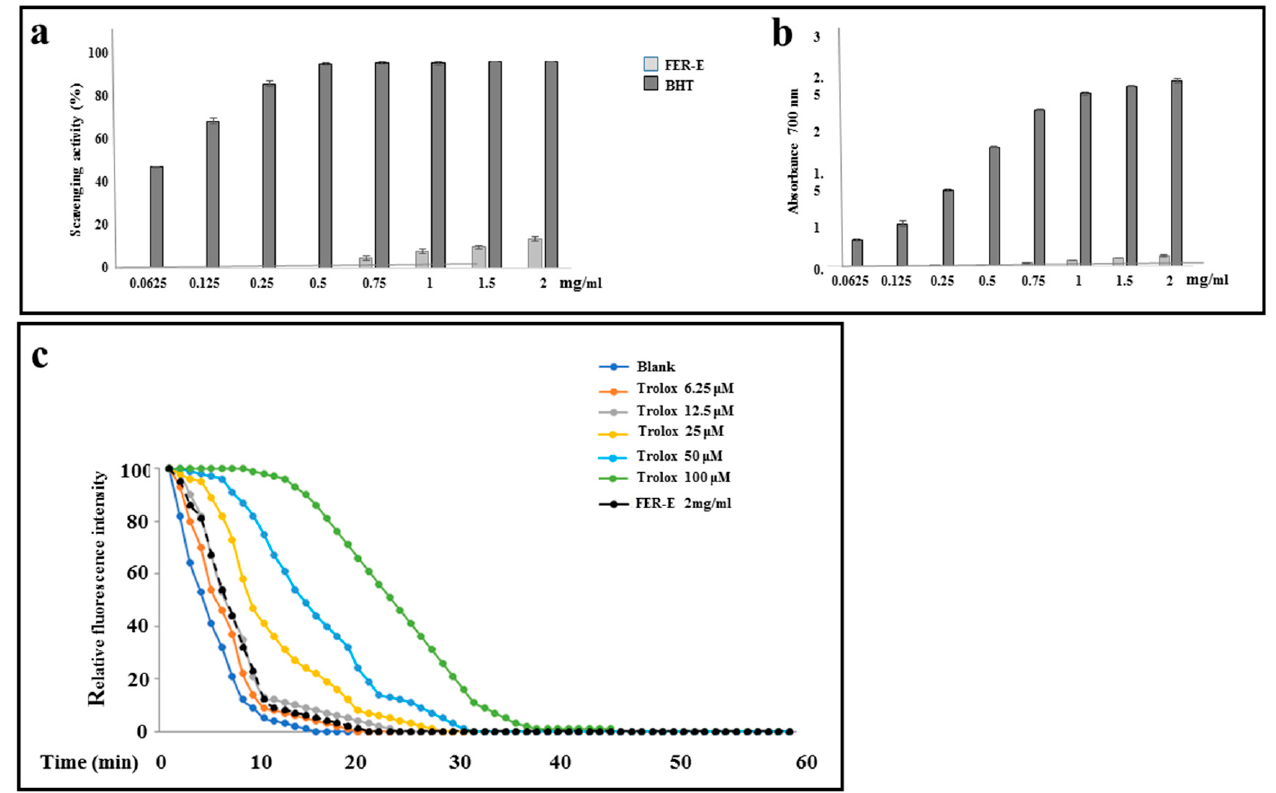
Figure 3. In ( a , b ) free radical scavenging activity (DPPH assay) and Reducing power of FER-E are reported, respectively. Reference standard: BHT (for both panels). In ( c ) the results obtained by the ORAC test are displayed, according to the manufacturer’s instructions in black 96-well plates. The fluorescence measurements, made at 485 nm excitation and 535 nm emission respectively, were carried out every 60 s, over a total measurement period of 60 min. AAPH was added into each well to start the generation of ROS. Initially, a standard antioxidant curve was created using different concentrations of Trolox (0–50 µ m) in PBS. The antioxidant capacity, expressed as the area under curve (AUC), was calculated for each Trolox Concentration. Curves showing the loss of fluorescence were constructed for different concentrations of Trolox and, for completeness, a “blank sample” was also measured. Finally, our sample FER-E (2 mg/mL) was evaluated and compared to the other samples examined. This assay was carried out in triplicate and a representative experiment is